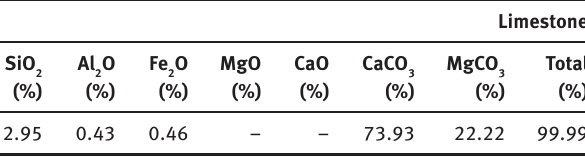
Table 2 Aggregates chemical